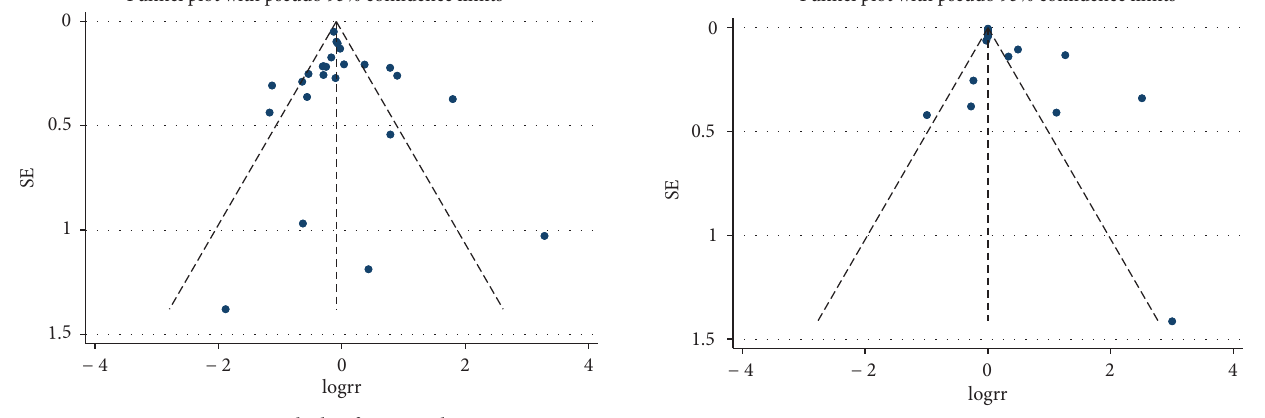
6: Funnel plot for severe